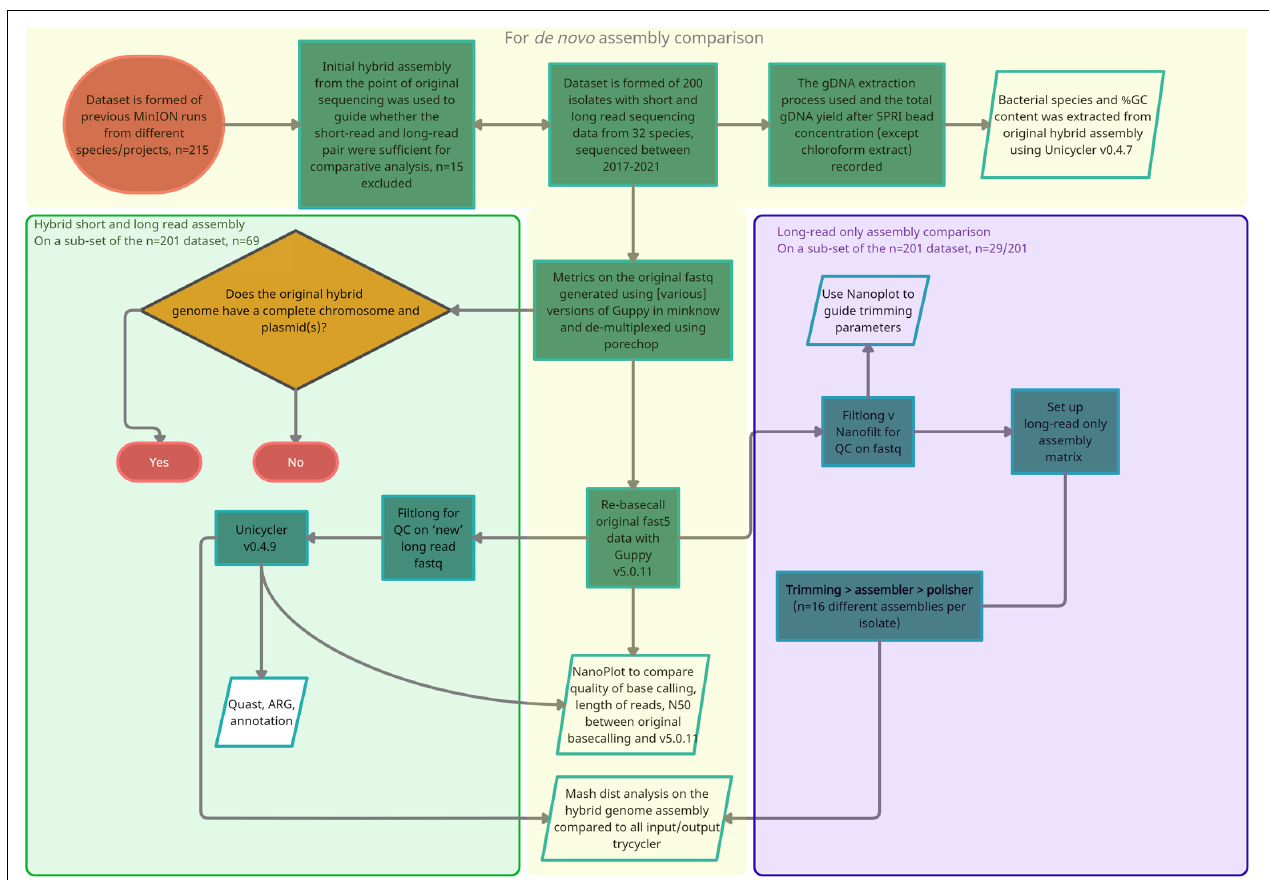
FIGURE 1 | A flow diagram summarizing the approach and methods taken for the three stages of analysis. (1) Orange, Isolate selection, re-basecalling with Guppy v.5.0.11 and comparison of long read metrics, (2) green, Repeat hybrid assembly with Unicycler v0.4.9 and re-basecalled long reads as input (–1 parameter), (3) purple, Additional long-read only assembly comparison.